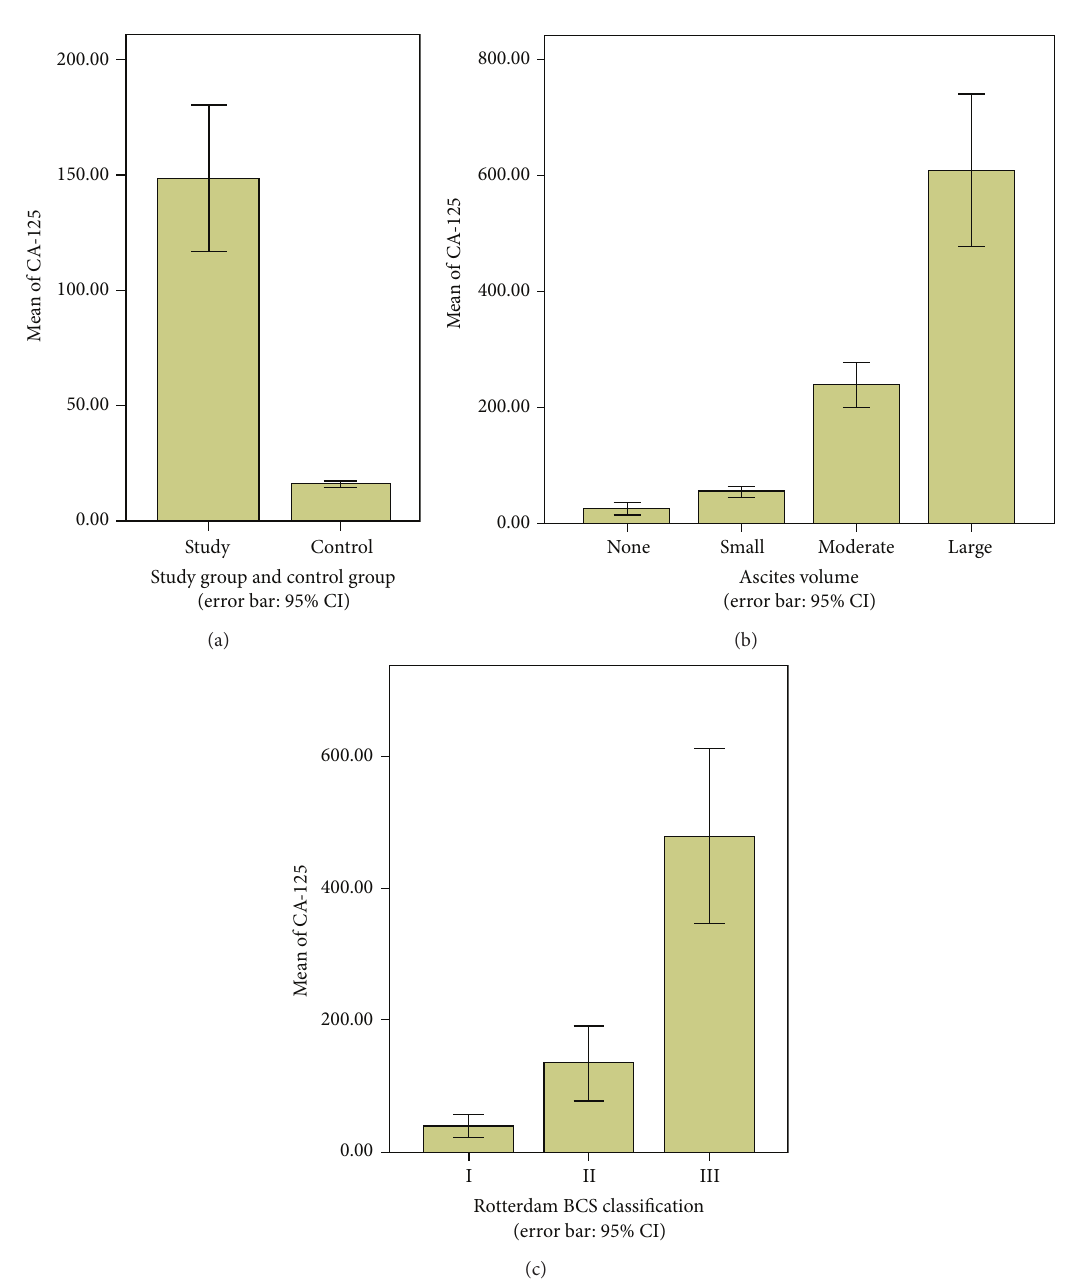
Figure 1: Serum level of CA-125 (U/mL). (a) The comparison between patients with Budd-Chiari syndrome (BCS) ( 𝑛 = 243 ) and healthy volunteers ( 𝑛 = 120 ). (b) The comparison among BCS patients with different volume of ascites, no ascites ( 𝑛 = 108 ), small volume ( 𝑛 = 75 ), moderate volume ( 𝑛 = 21 ), and large volume ( 𝑛 = 39 ). (c) The comparison among BCS patients with different Rotterdam BCS score, grade I ( 𝑛 = 107 ), grade II ( 𝑛 = 99 ), and grade III ( 𝑛 = 37